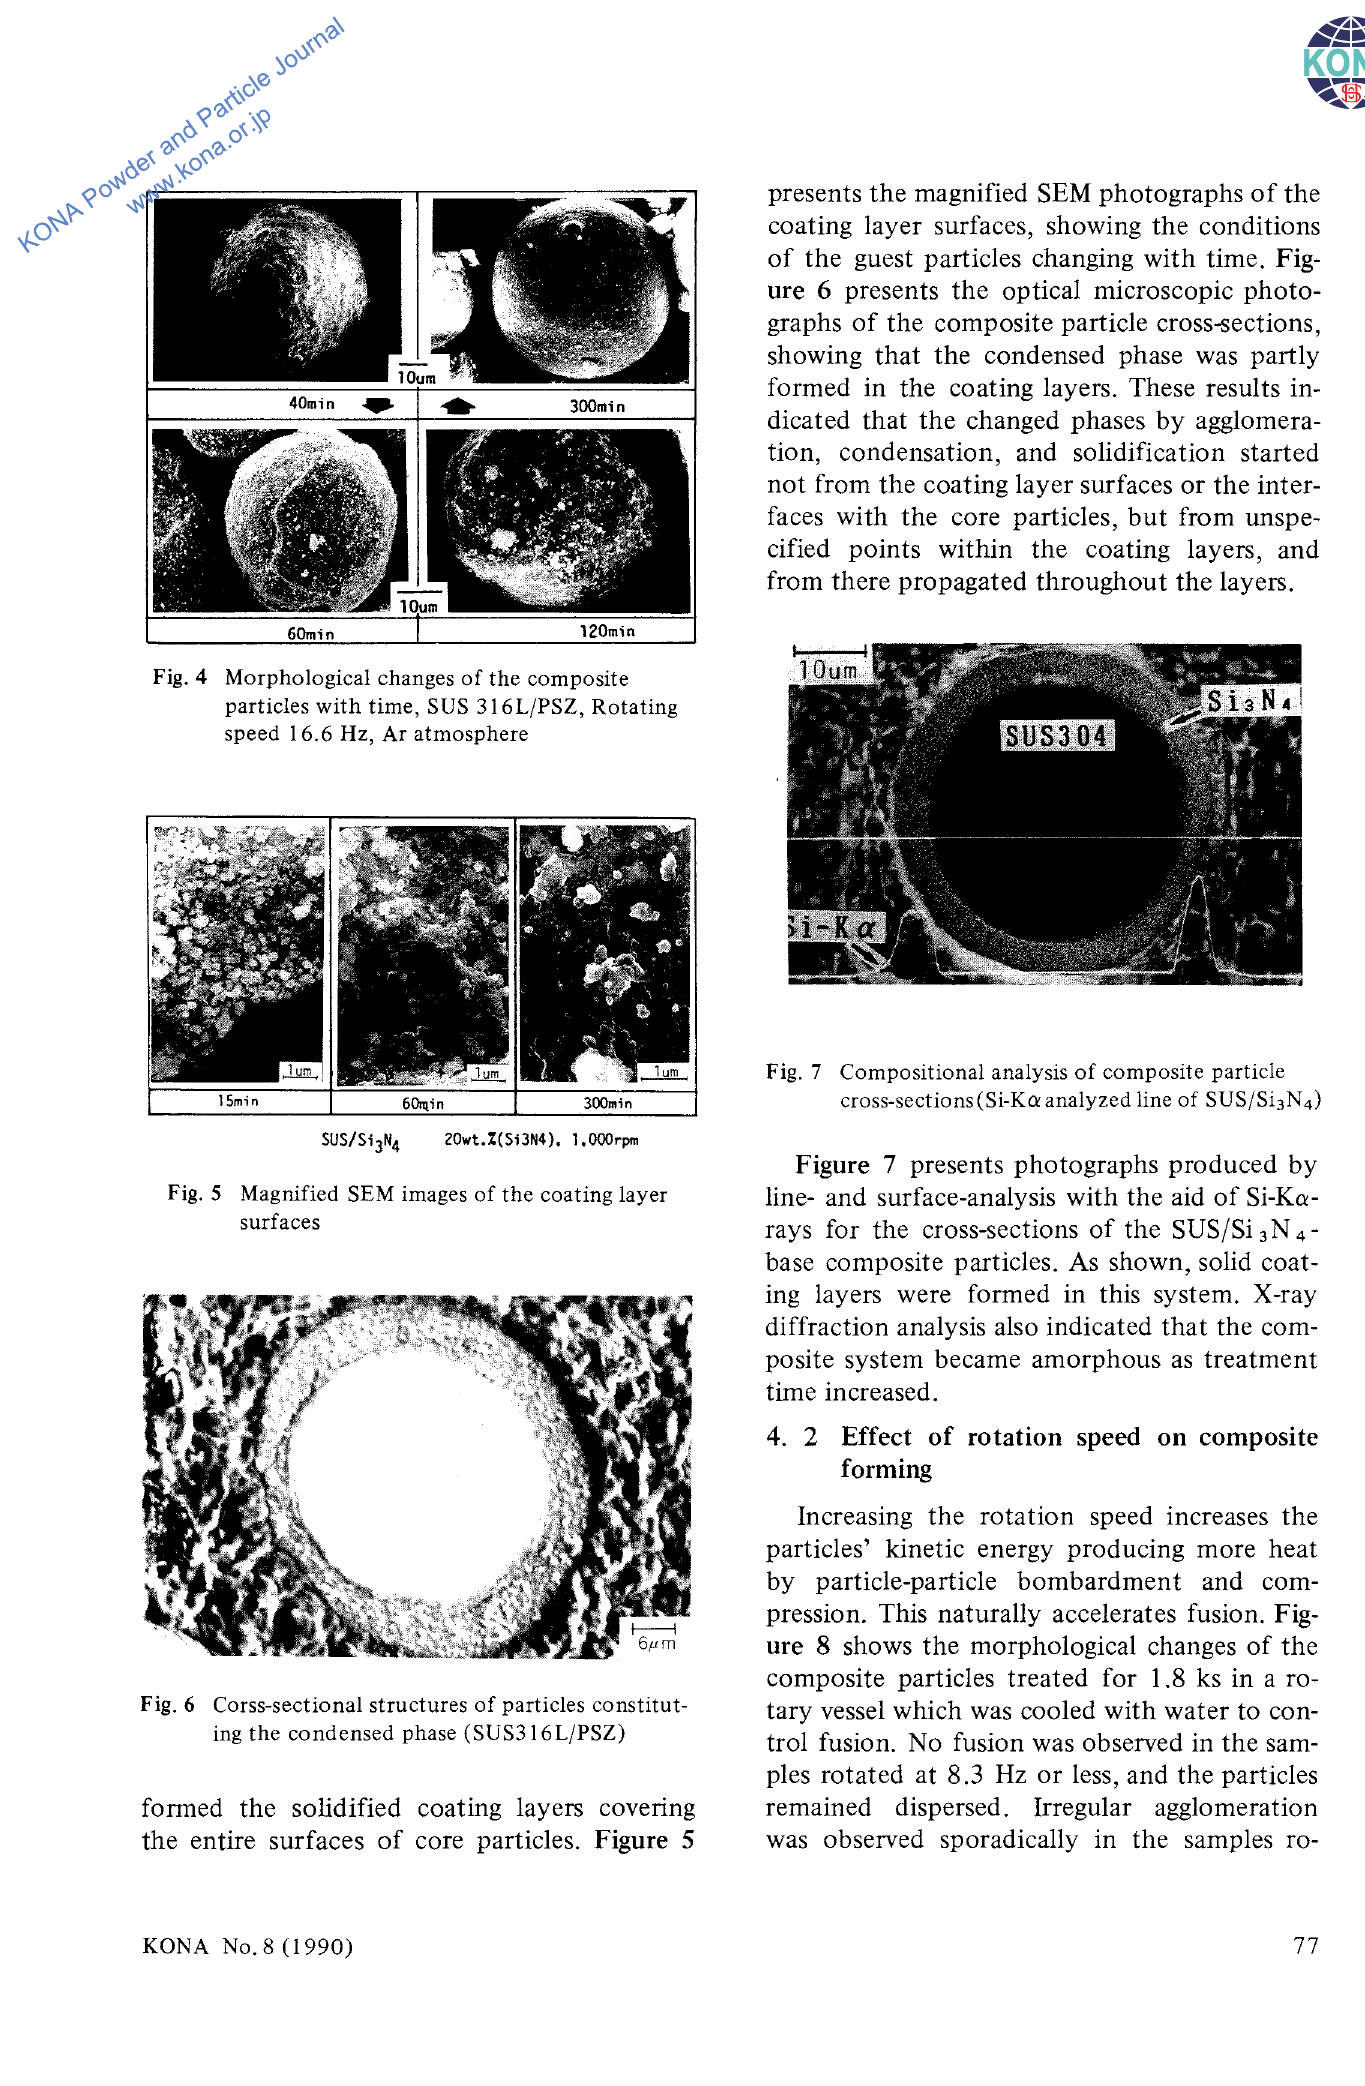
Fig. 6 Corss-sectional structures of particles constitut ing the condensed phase (SUS316L/PSZ) formed the solidified coating layers covering the entire surfaces of core particles. Figure 5